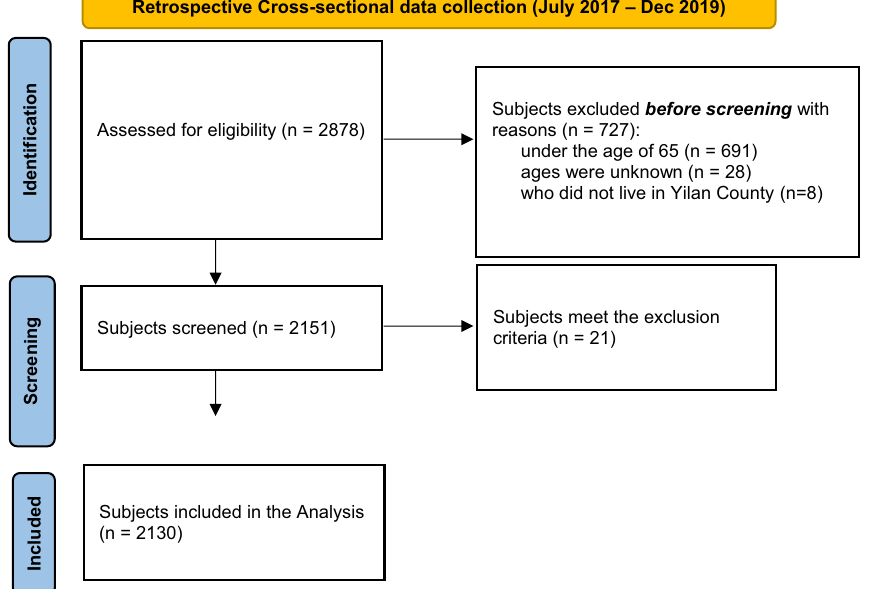
Figure 1. Flow chart depicting the number of individuals in our research that were included and excluded.